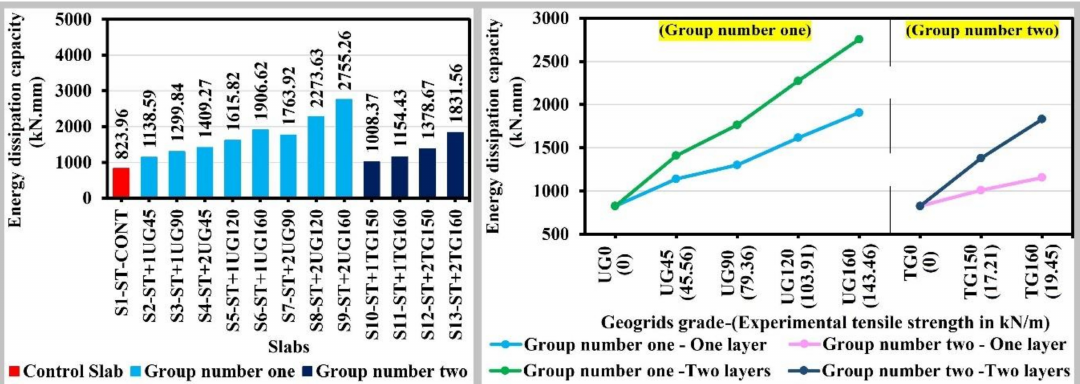
Figure 15. The energy dissipation values, and the relation between the energy dissipation and the tensile strength of geogrids or the number of geogrids’ layers.